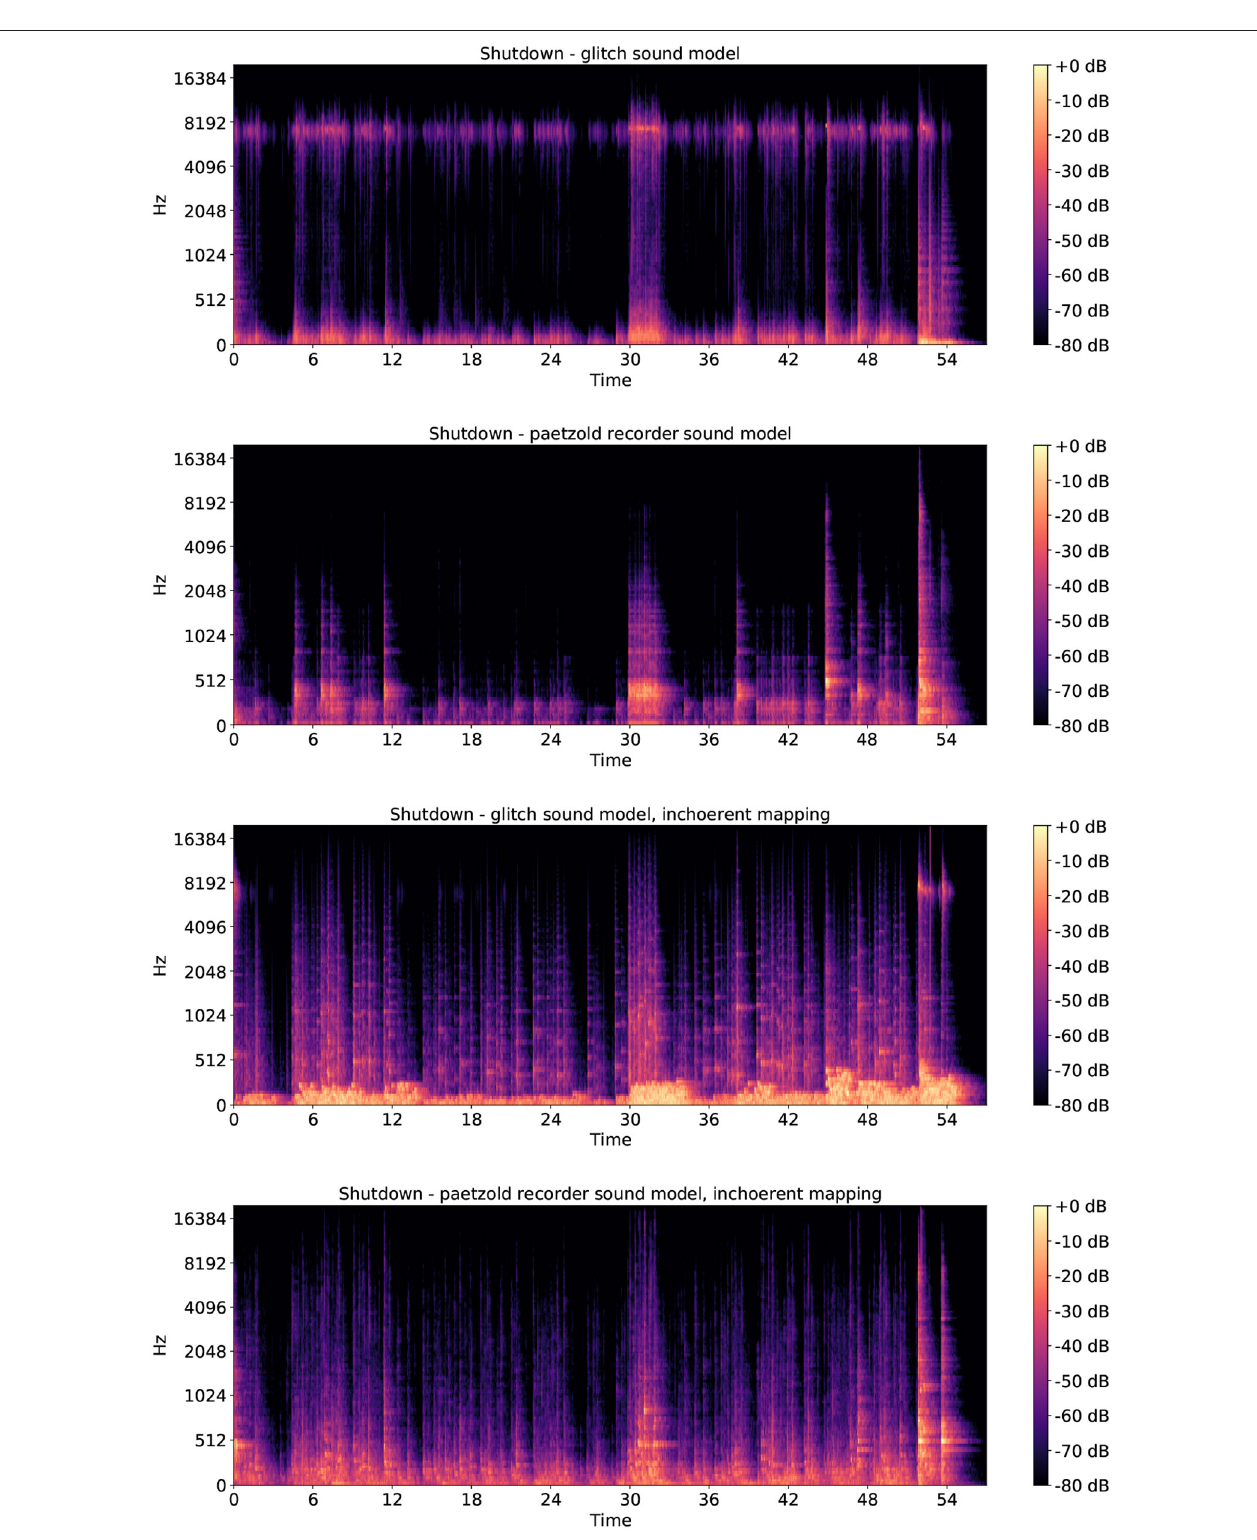
FIGURE 8 | Spectrograms of the four computer shutdown sonifications. From top to bottom: shutdown glitch sound model, shutdown Paetzold recorder sound model, shutdown glitch sound model incoherent mapping, shutdown Paetzold recorder sound model incoherent mapping.